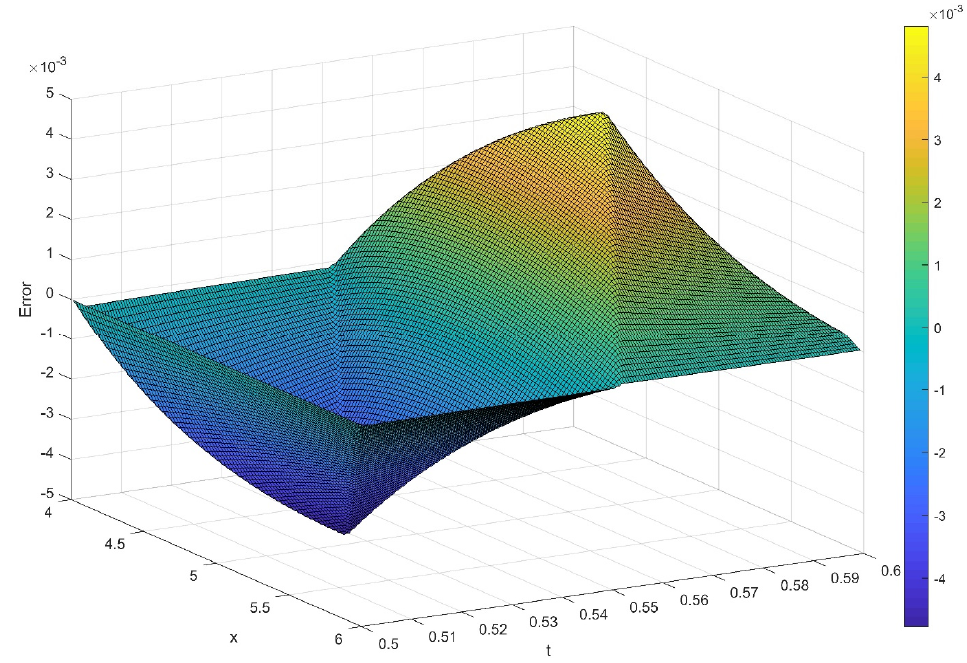
Figure 10. The function u analytic ( t , x ) − u num ( t , x ) , i.e., the difference between the analytical solution and the LH method for h = 5.2 · 10 − 4 as a function of space and time for Experiment